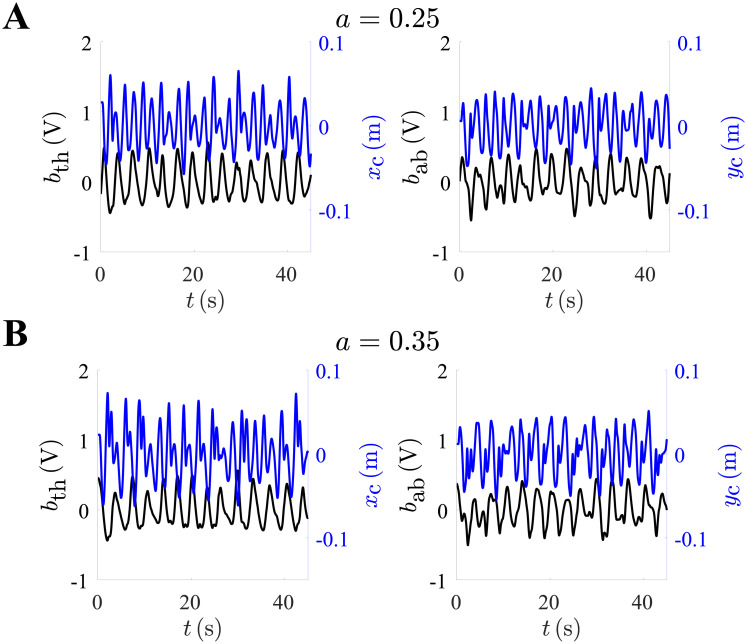
Expansion of the thorax and the abdomen from a representative participant.Time-series for expansion of the thorax bth vs. cursor’s position xc (left), and the abdomen expansion bab vs. yc (right). (A) Representative trial given a = 0.25, and (B) trial with a = 0.35, from the same participant in Fig 2A.